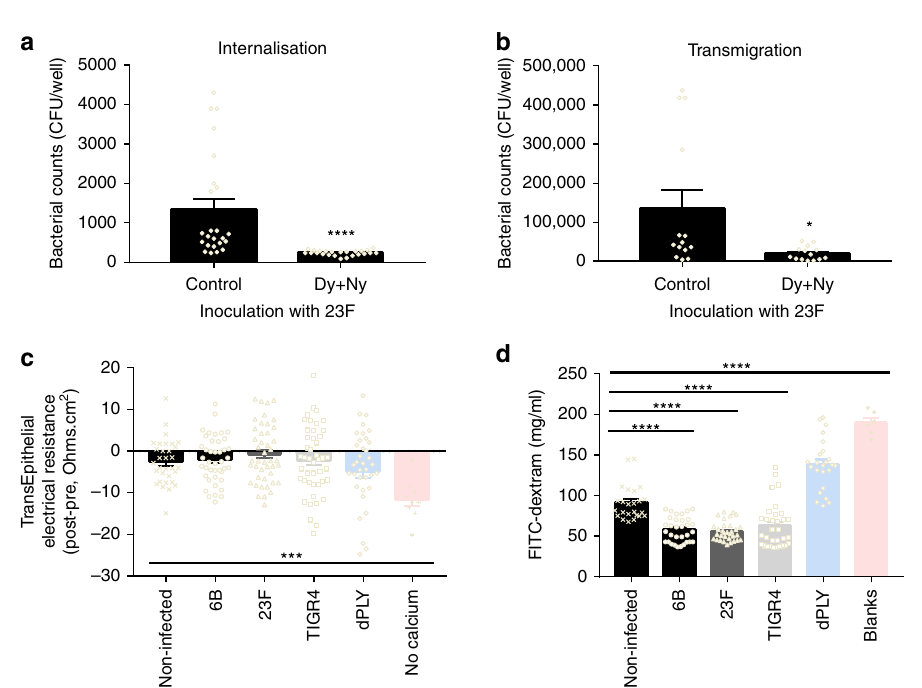
Fig. 4 Pneumococcal micro-invasion is endocytosis-dependent and occurs without loss of barrier function. a , b Detroit 562 cells were treated with dynasore and nystatin for 30 min prior to and during incubation with 23F, for 1 h. a Intracellular bacteria were quanti fi ed using a gentamicin protection assay and CFUs counted (**** P = < 0.0001, Mann – Whitney). b Transmigrated bacteria after 1 h were counted by CFUs (* P = 0.013 Mann – Whitney). N = 4. c , d Cells were co-infected with pneumococci for 3 h on transwell inserts and barrier function was measured. c Trans-epithelial electrical resistance (TEER) was compared before and after exposure to pneumococci. N = 9. Calcium withdrawal was used as a positive control (*** P = 0.0013, unpaired T- test, n = 3). d Permeability was assessed by leak to 4 kDa FITC-dextran, collected from basal chamber. N = 4. **** P = < 0.0001 comparing non-infected against pneumococci (Kruskall – Wallis). Blank inserts were used as a positive control (Mann – Whitney). Error bars represent